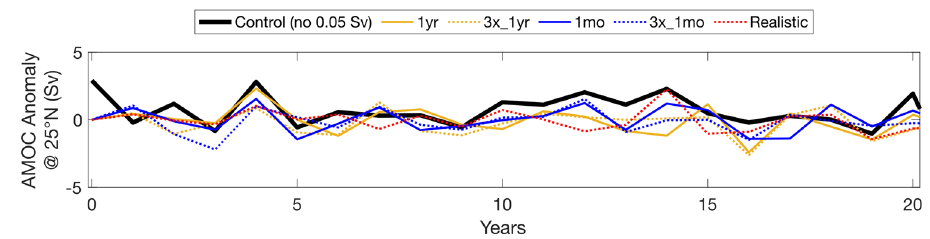
Fig. 3 Calculated mean annual AMOC mass transport anomalies from the experimental simulations remain low and do not deviate from the Control. For comparison, the mean annual AMOC anomalies of the Control with no background meltwater fl ux scenario (black line) are